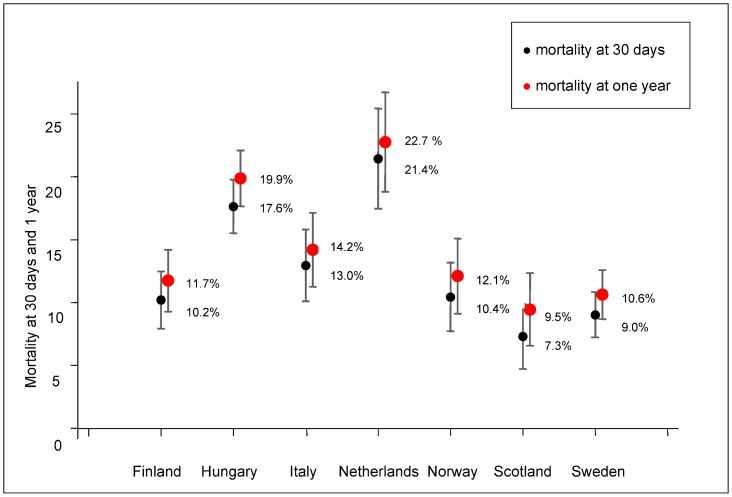
Risk adjusted mortality rates at 30 days and at 1 year.
aAdjusted for gestational age (GA), sex, intrauterine growth (small for gestational age), Apgar score at five minutes, parity and multiple births. A confidence interval: 95%.